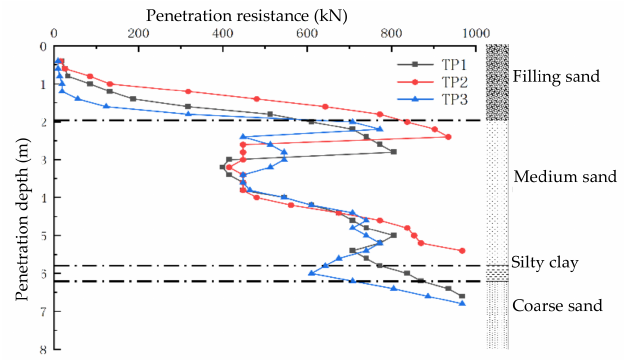
Figure 2. Penetration resistance curve for condition a .